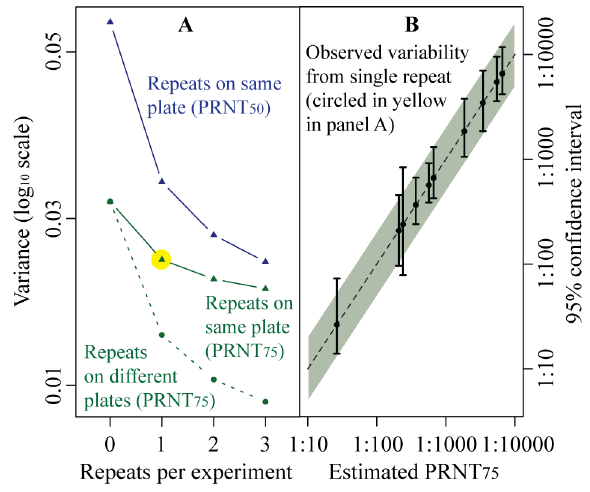
Figure 4. ( A ) Variance in absolute titers by the number of repeat sets of dilutions and where the repeats are performed (either the same plate or on different plates). All titers estimated using cloglog regression. ( B ) Observed titer variability. Each solid line represents the 2.5% and 97.5% quantiles from the titers estimated from the serum pool – virus combinations listed in Table 1. The shaded area represents asymptotic 95% confidence intervals calculated using a single variance estimate from all assays (represented by the yellow circle in panel A).